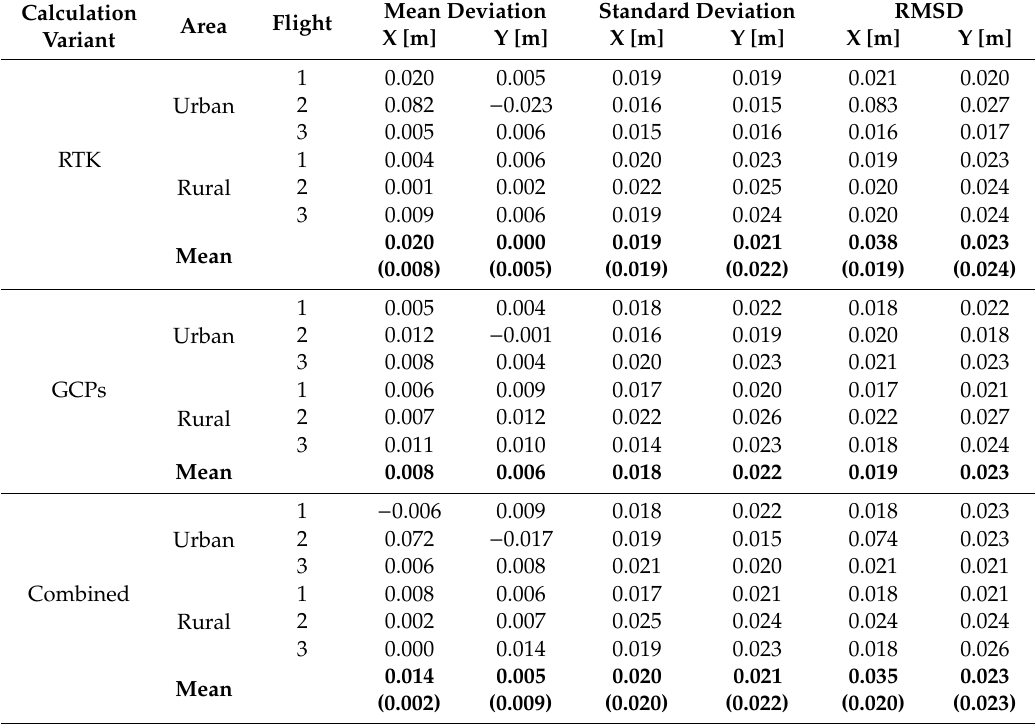
Table 7. Horizontal checkpoint accuracy